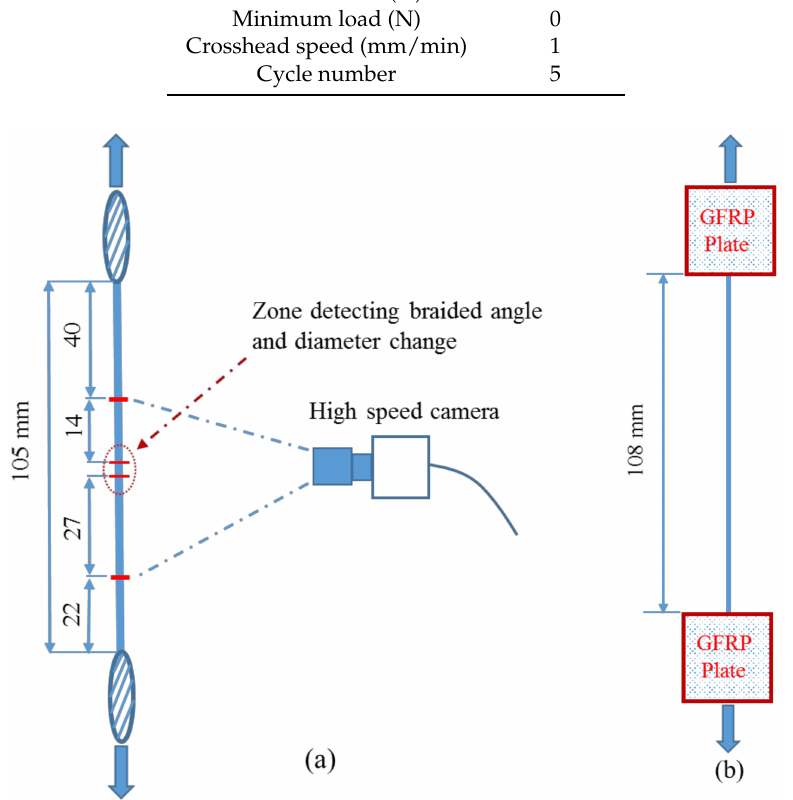
Figure 2. Experimental setup for rope ( a ) and strand ( b